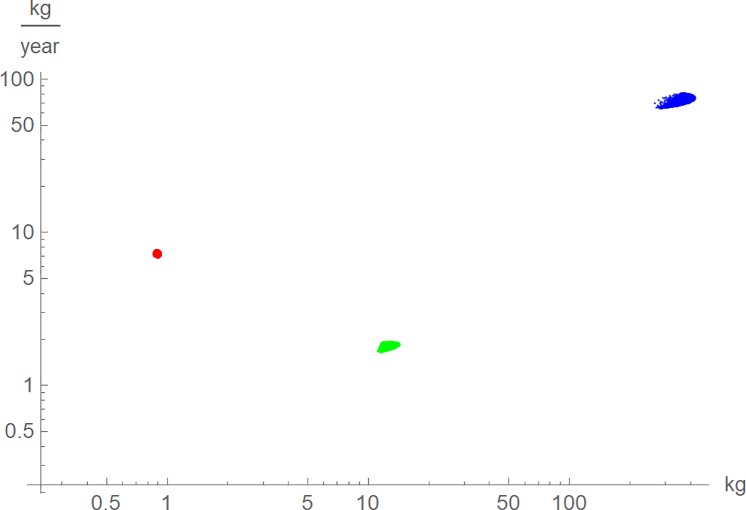
Maximal growth rate, m´(tinfl), and mass at the inflection point, minfl = m(tinfl), for near-optimal growth curves m(t) for chicken (red), alligators (green) and tenentosaurs (blue).